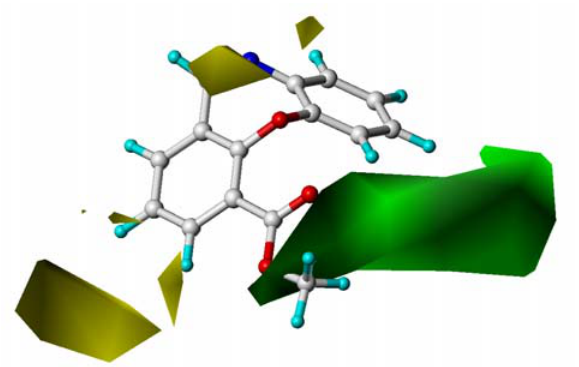
Figure 3. Contour maps of CoMFA steric regions in combination with compound 10 . Steric field: Green contours (80% contribution) indicate regions where bulky groups increase activity, while yellow contours (20% contribution) indicate regions where bulky groups decrease activity. Compound 10 is depicted in ball and stick representation, coloured by atom type (white C, blue N, red O, cyan